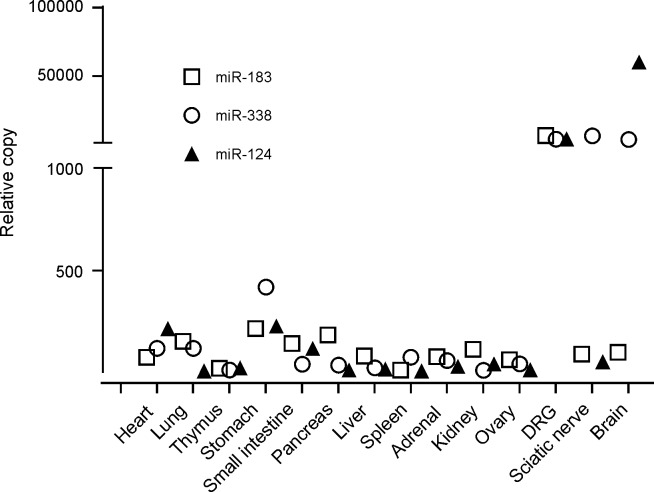
miRNAs enriched in peripheral nerve tissues.MiR-124, miR-183 and miR-338 expression levels were over 20 fold higher in DRG and sciatic nerve tissues compared to other non-nerve tissues and organs.